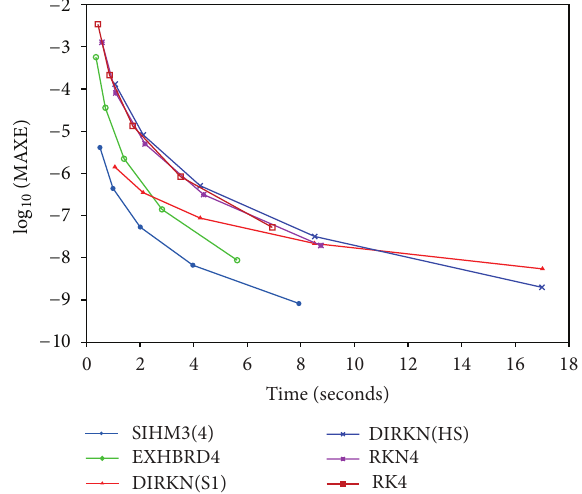
Figure 2: The efficiency curves for SIHM3 (4) method for Attili problem with ℎ = 0.5/2 𝑖 , 𝑖 = 1,...,5 .